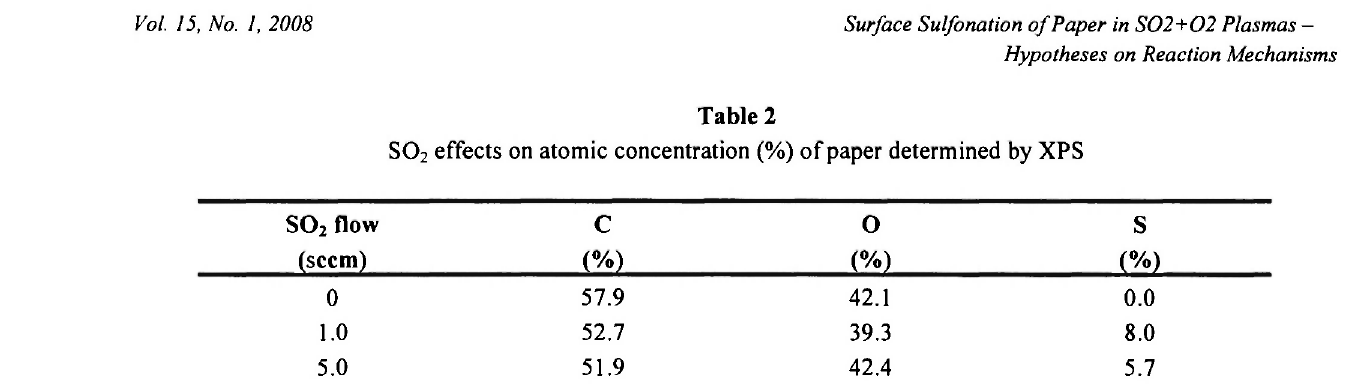
S0 2 effects on atomic concentration (%) of paper determined by XPS